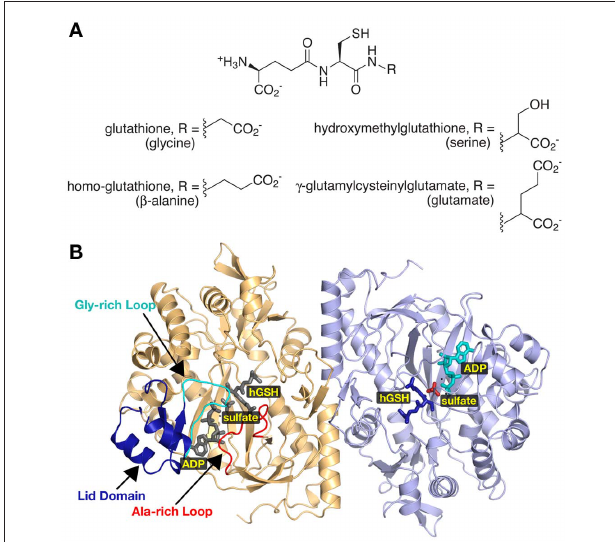
Figure 4 | Diversity in plant glutathione synthetases. (A) The chemical structures of glutathione analogs synthesized by various plants are shown. All share the core γ -glutamylcysteine structure with modifications to the third amino acid position as indicated. (B) Ribbon diagram of the homoglutathione (hGS) dimer (Galant et al., 2009). Monomers are colored gold and blue, respectively. The lid domain (dark blue), glycine-rich loop (cyan), and the alanine-rich loop (red) are highlighted in the gold monomer. Positions of bound ADP, sulfate, and homoglutathione are highlighted in the blue monomer with corresponding ligands colored gray in the